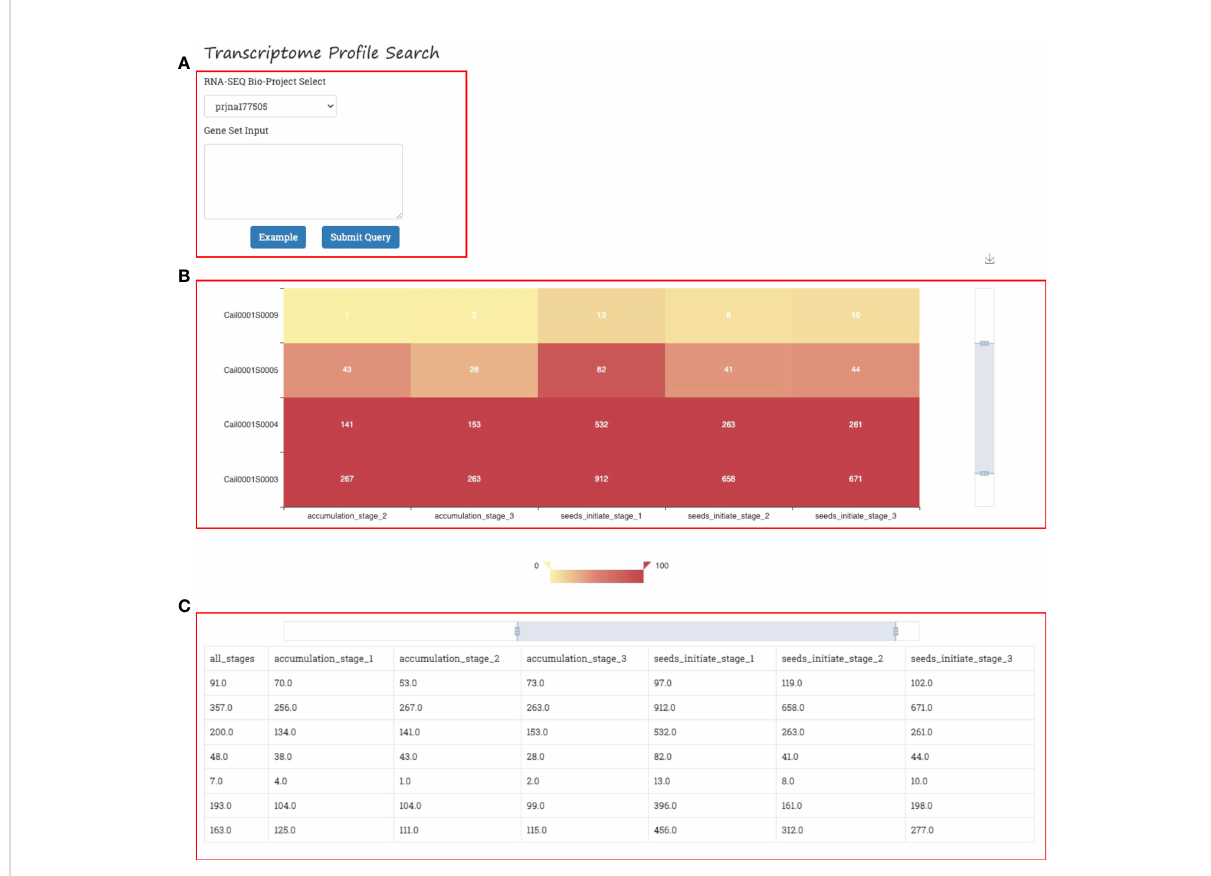
FIGURE 6 Gene expression visualizer in GROP. (A) Input panel of the transcriptome version and gene set. (B) Gene expression heatmap for different gene sets, environments, and developmental stages. (C) Gene expression data